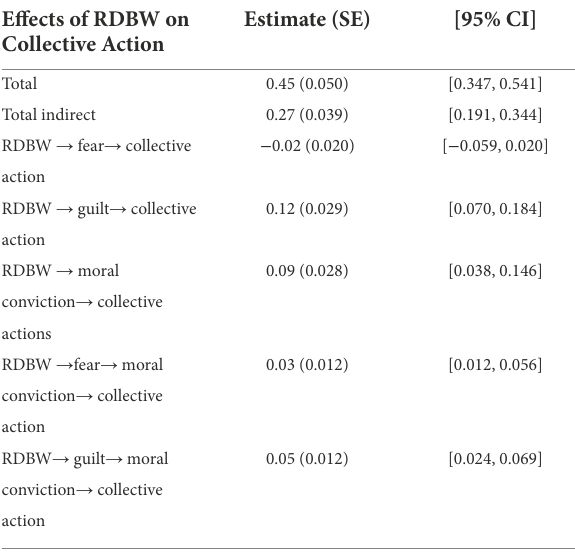
TABLE 3 Total, total indirect, and specific indirect effects of relative deprivation on behalf of women (RDBW) on Collective action. Effects of RDBW on Collective